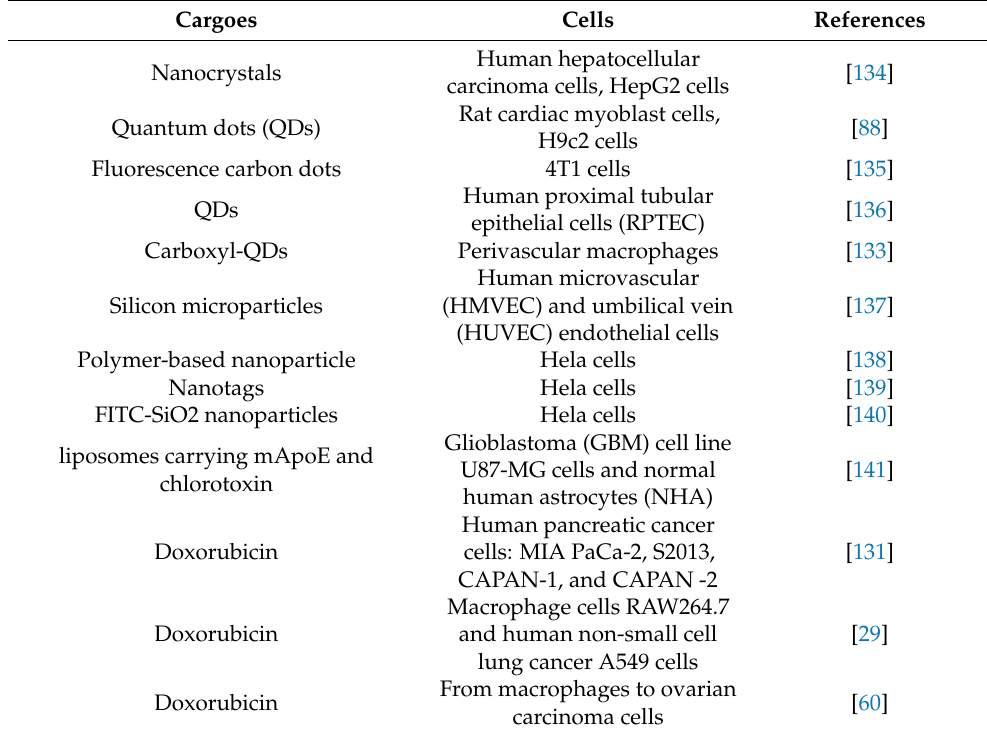
Table 2. Transfer of nanoparticles and drugs via TNTs. Cargoes